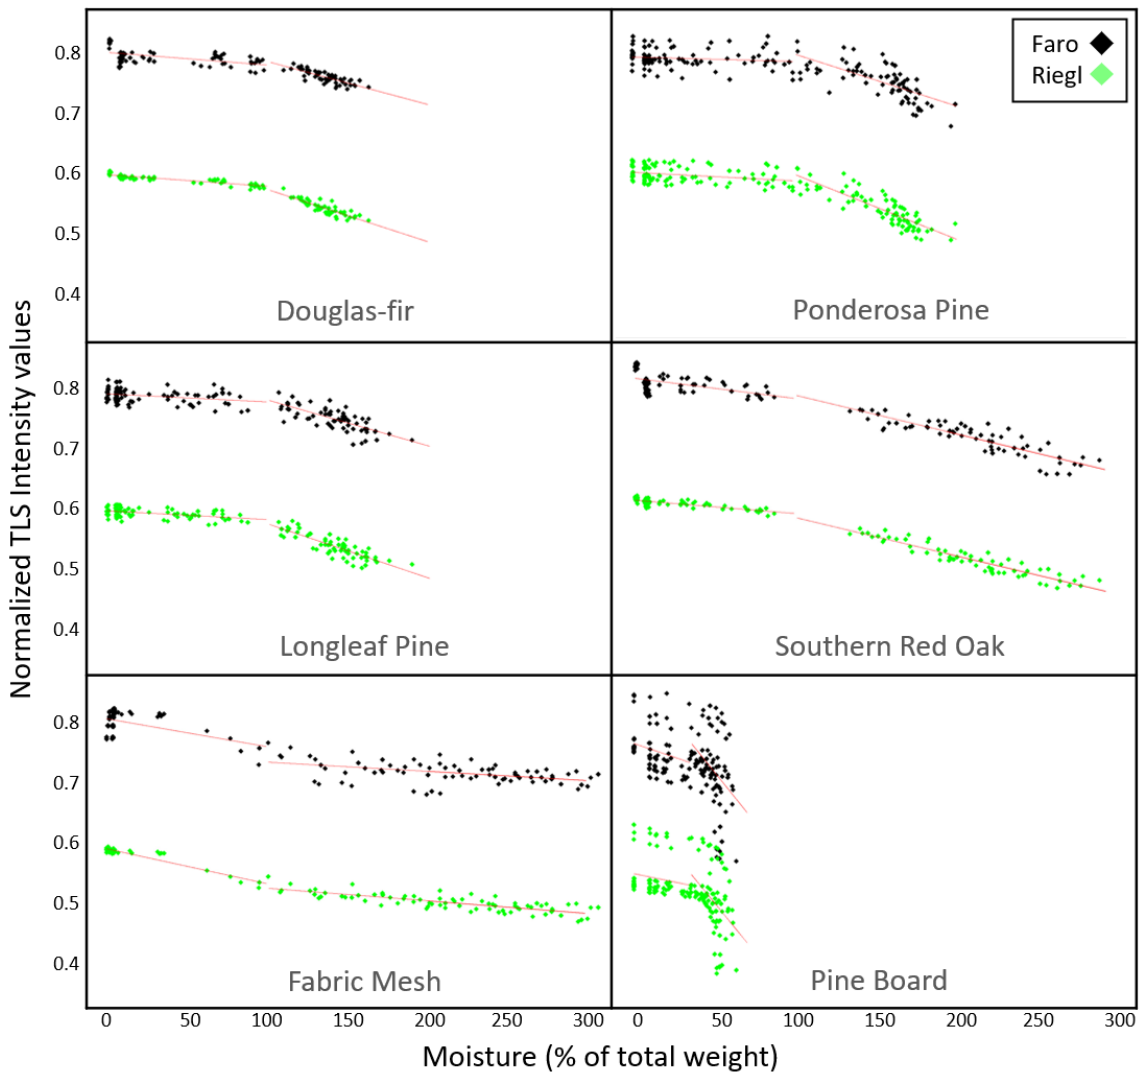
Figure 7. Mean normalized intensity values of the samples placed at 3 m from FARO and RIEGL scanners. Regression lines from a broken stick linear regression model are added. The selected break location was 100% for all sample materials except pine board for which the break was located at 40%.